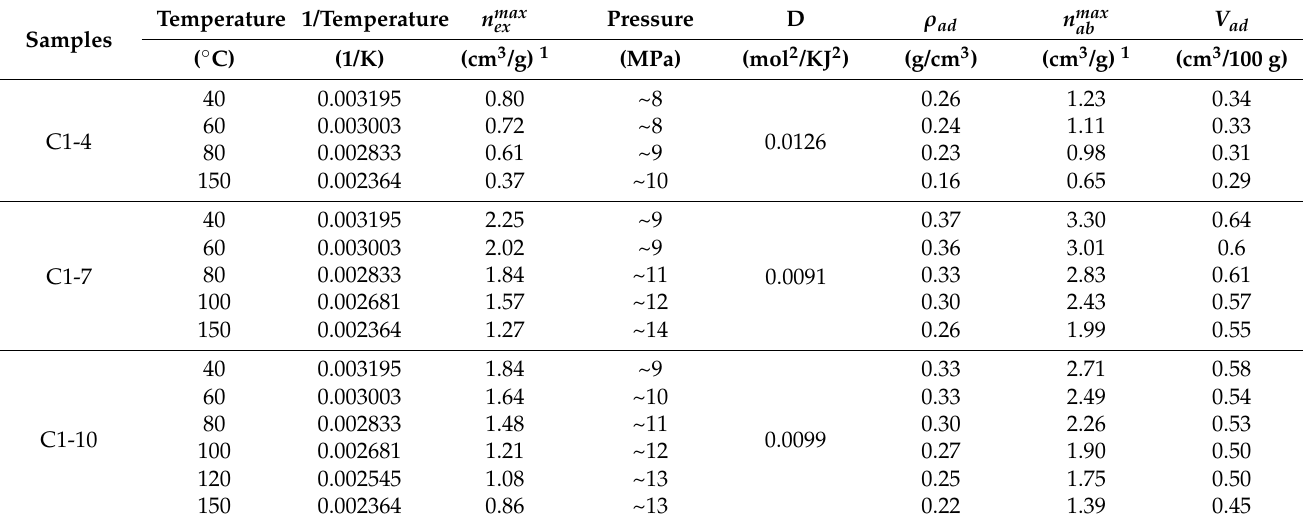
Table 4. The adsorption parameters of three selected samples (C1-4, C1-7 and C1-10).